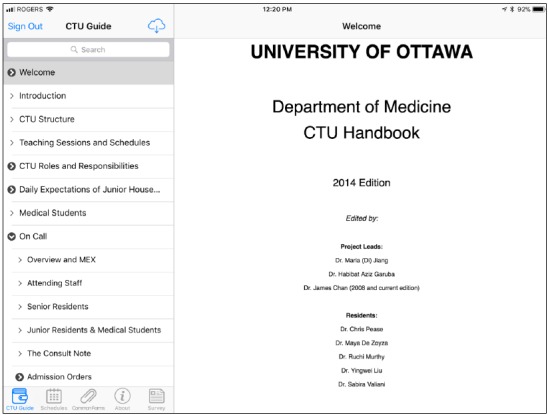
Screenshot of CTU Handbook App